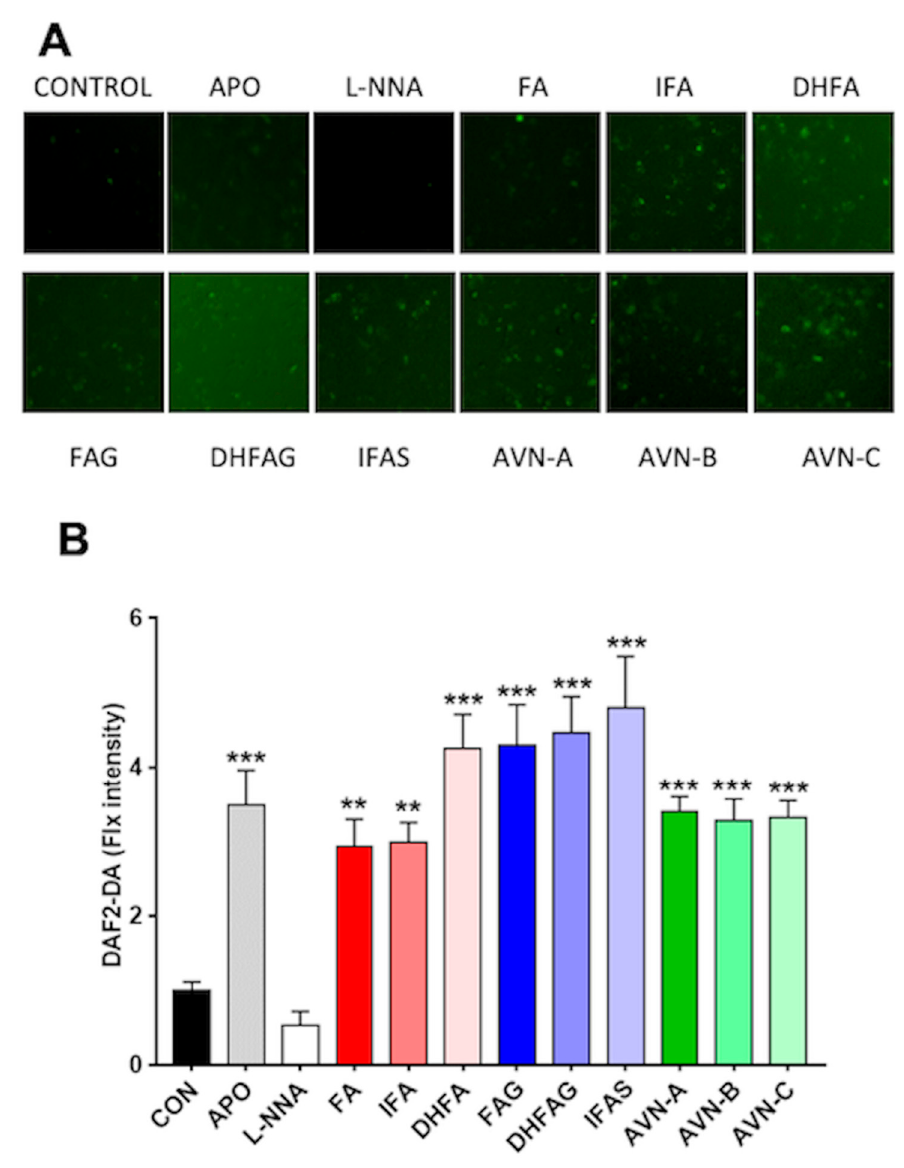
Figure 3. NO levels in HUVEC as visualized by DAF-2DA fluorescence ( A ) and relative fluorescence intensities ( B ), after pre-treatment with the oat phenolics and metabolites (1 μ M), ferulic acid (FA) isoferulic acid (IFA), dihydroferulic acid (DHFA), FA glucuronide (FAG), DHFA glucuronide (DHFAG), IFA sulfate (IFAS), avenanthramide A (AVN-A) avenanthramide B (AVN-B) avenan- thramide C (AVN-C), apocynin (APO, 100 μ M) or L-NG-Nitro-Arginine (L-NNA, 100 μ M) for 24 h. Images in panel A are a representative example, whereas data with error bars in panel B represent the average ± SEM of 6 independent experiments and are expressed as fold change (control, CON, = 1). * = p < 0.05, ** = p < 0.01, *** = p < 0.001 vs. control ( n = 6).